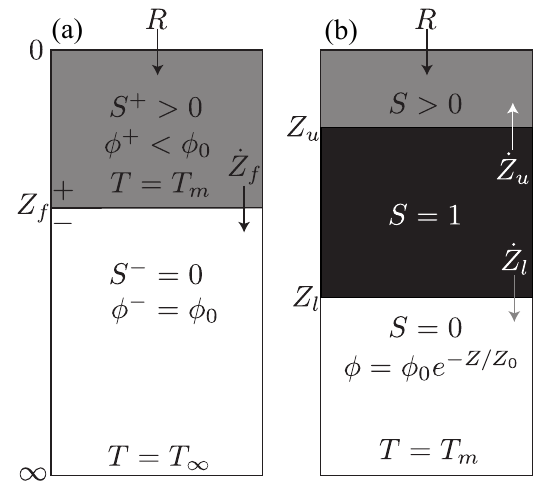
Figure 2. Schematic of the test problems considered in (a) Sect. 3.1 and (b) Sect. 3.3. In both panels, rain falls at a rate R on the surface of the snow. White shading indicates dry snow ( S = 0), grey indi- cates partially saturated snow (0 < S < 1), and dark shading indi- cates fully saturated snow ( S = 1). In panel (a) , the snow is initially cold with T = T ∞ and dry, with uniform porosity φ 0 . The rainwa- ter percolates through the snow, refreezes at the interface Z f (t) , and releases latent heat that warms the snow. The refreezing decreases the porosity in the upper region so that φ + < φ 0 . In panel (b) , the snow is temperate, T = T m , with a porosity profile that decays ex- ponentially with depth. After the snow fully saturates two saturation fronts emerge with Z l propagating downward and Z u